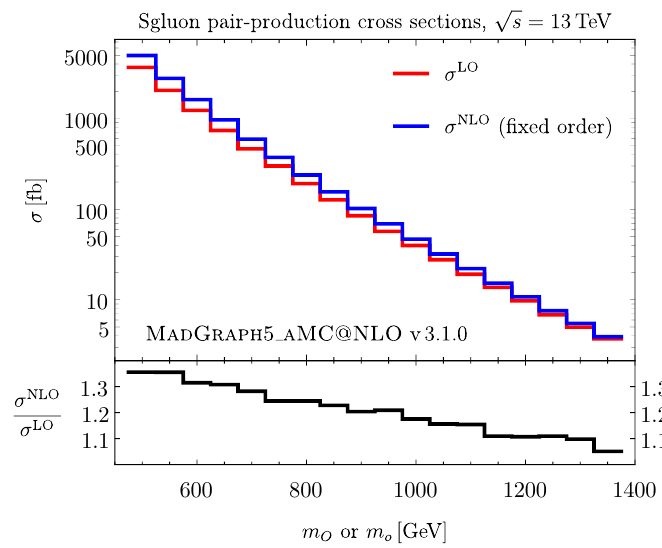
Figure 6 . Cross sections of pair production of scalar or pseudoscalar sgluons. In the upper panel we display results at leading order (LO) and next-to-leading order (NLO) in the strong coupling. The lower panel shows the K factor for this process, given by the ratio of the NLO result to the LO